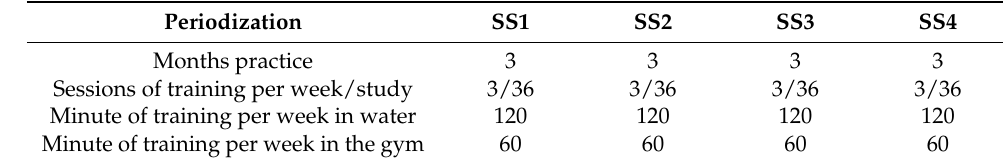
Table 2. Periodization of training by age